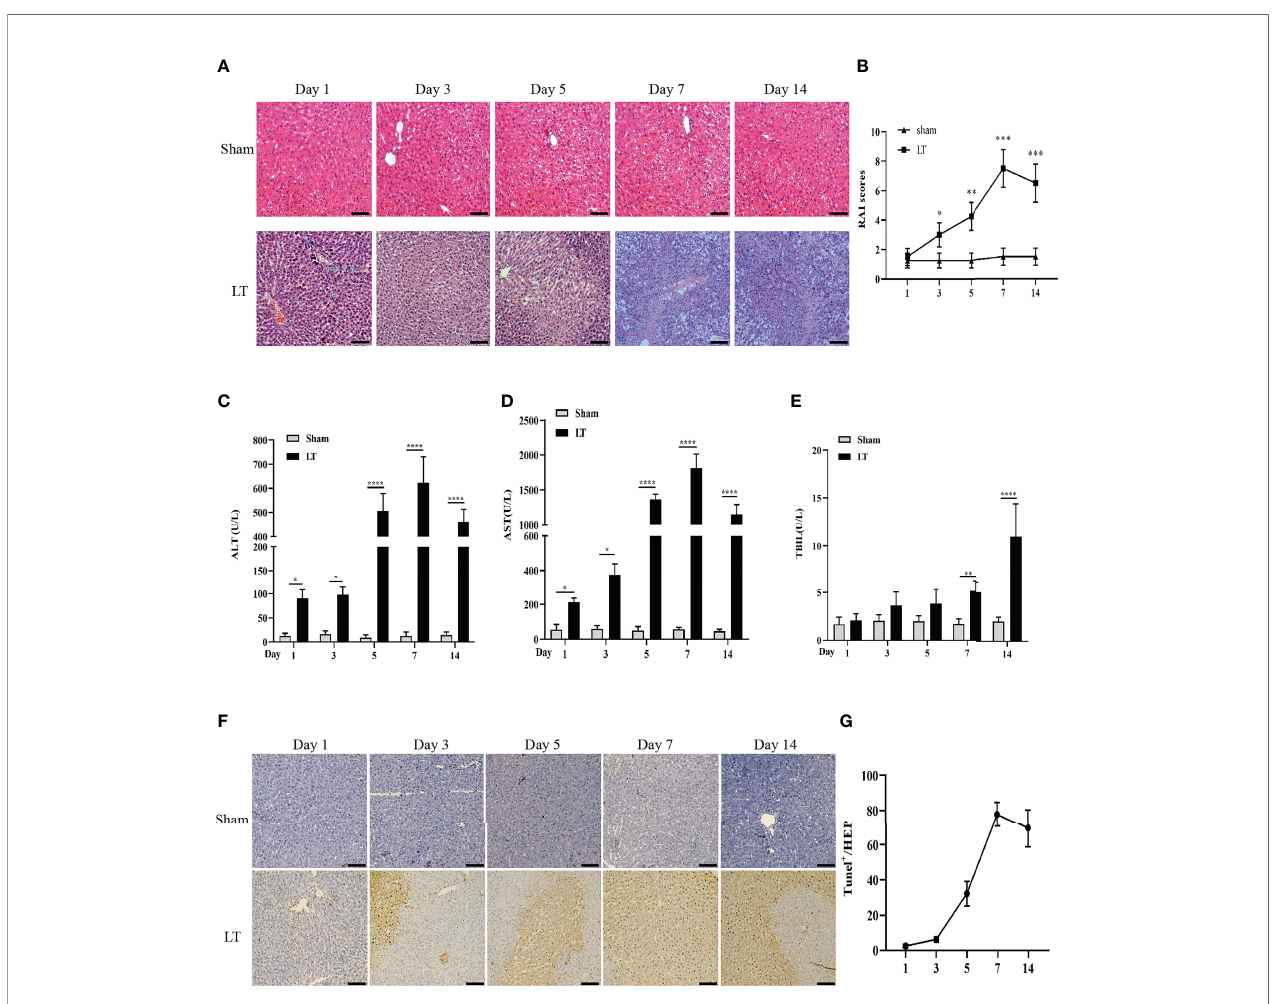
FIGURE 1 | AR responses in isograft and allograft groups. (A) Hepatic pathologic alteration following liver transplantation on days 1, 3, 5, 7, and 14 (magni fi cation, ×200; scale bar = 100 m m). (B) Histological classi fi cation was determined by RAI based on Banff ’ s scheme. (C – E) Serum ALT, TBIL, and AST levels on days 1, 3, 5, 7, and 14 following liver transplantation. (F, G) Hepatic apoptosis detected by TUNEL following liver transplantation on days 1, 3, 5, 7, and 14 (magni fi cation, ×200; scale bar = 100 m m). All differences denoted by asterisks were subjected to Student ’ s t-tests. The values are presented as mean ± SD (n = 6). * P < 0.05, ** P < 0.01, *** P < 0.001, **** P <